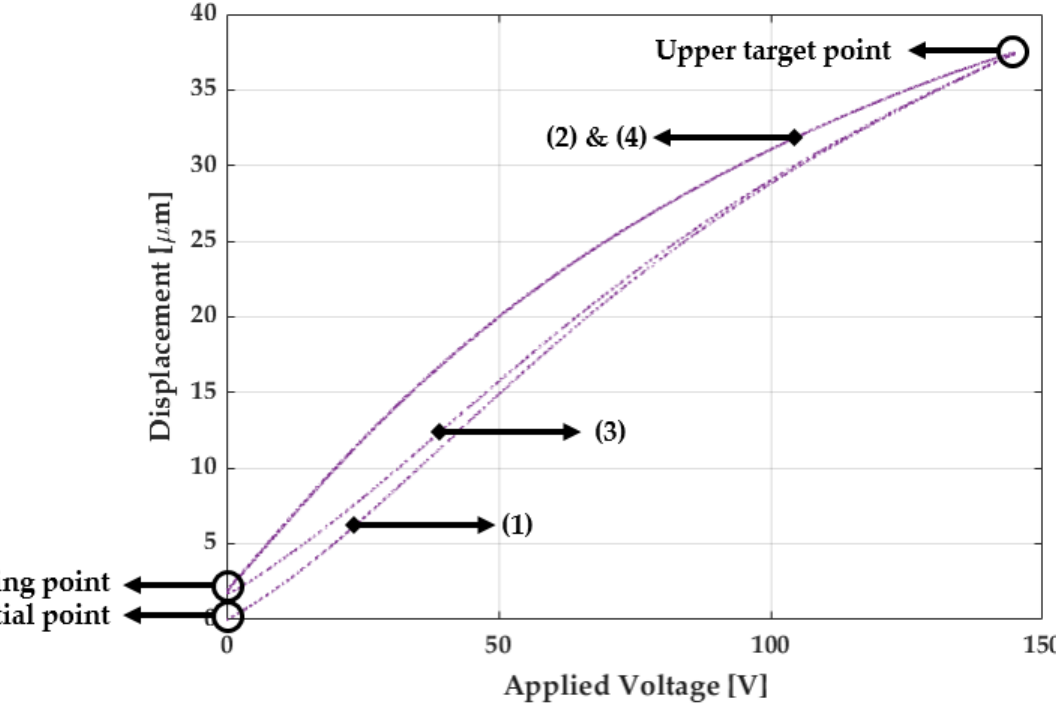
Figure 2. Hysteresis graph of the used